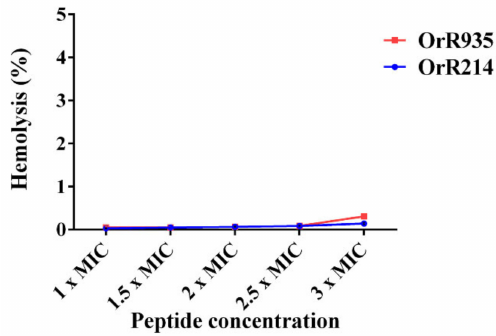
Figure 7. Hemolytic activity curves of the peptides on porcine erythrocytes. The release of hemoglobin was monitored at 385 nm by measuring the absorbance using a microplate